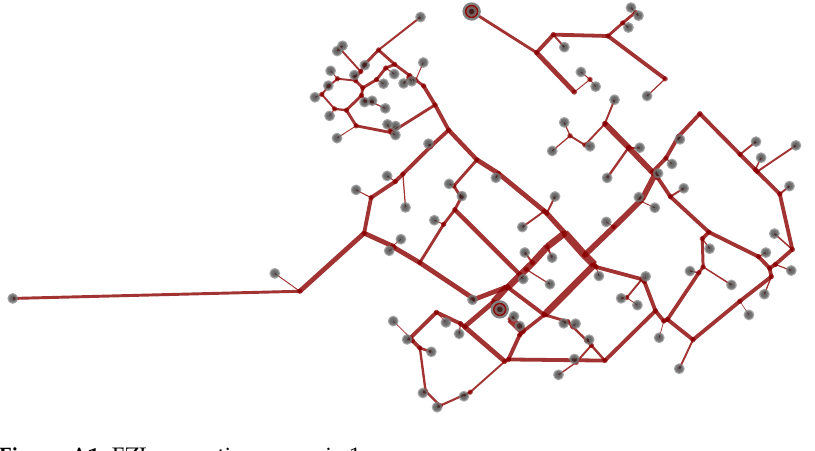
Figure A1. FZJ separation scenario